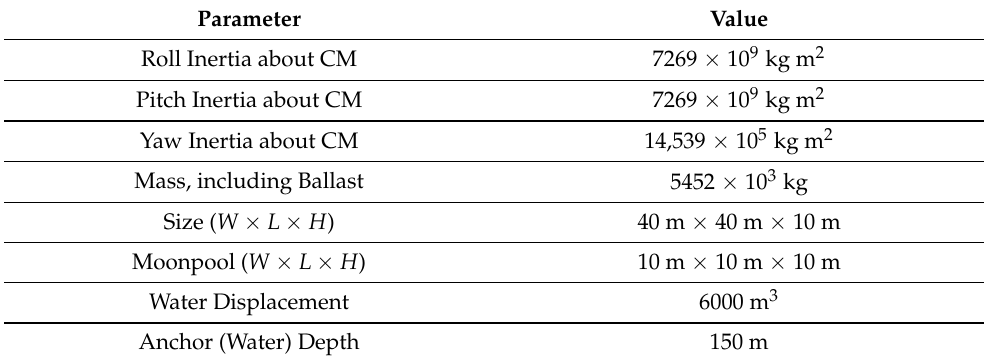
Table 2. Platform Parameters